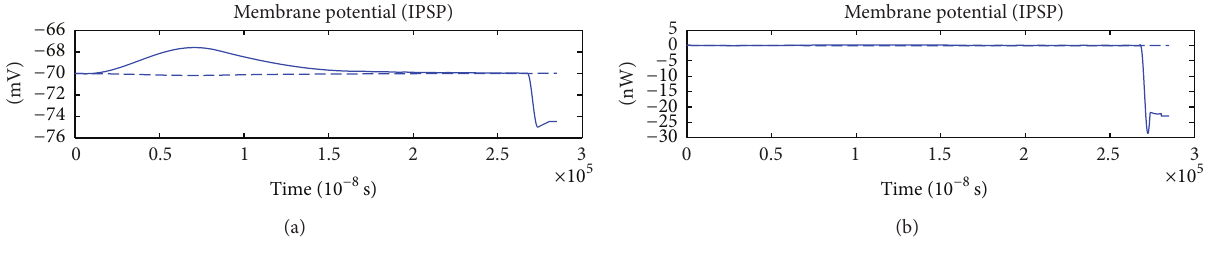
Figure 20: The IPSP and the corresponding energy function. 𝑟 0𝑚 = 0.0001 Ω , 𝑟 1𝑚 = 0.1Ω , 𝑟 2𝑚 = 1000 Ω , 𝑟 3𝑚 = 0.1 Ω , 𝑟 𝑚 = 1000 Ω , = 1 𝜇 F, 𝐿 = 50 𝜇 H, 𝑖 = −0.7 𝜇 A, and 𝑄 = 1 × 10 −5 𝜇 A. 𝐶 𝑚 𝑚 0𝑚